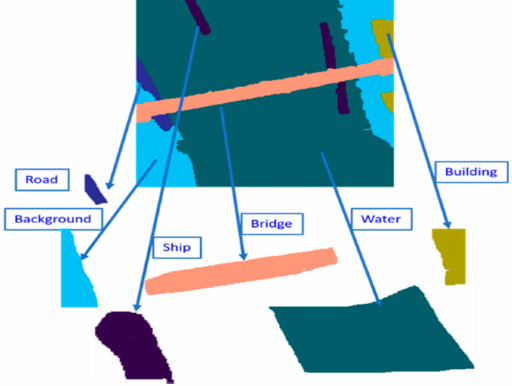
Figure 7. Object categorization using MKL over an image from RESISC45